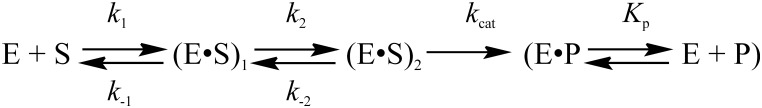
Kinetic mechanism of Nei processing of the DHU/Cpy- and DHU/tCO-substrates.